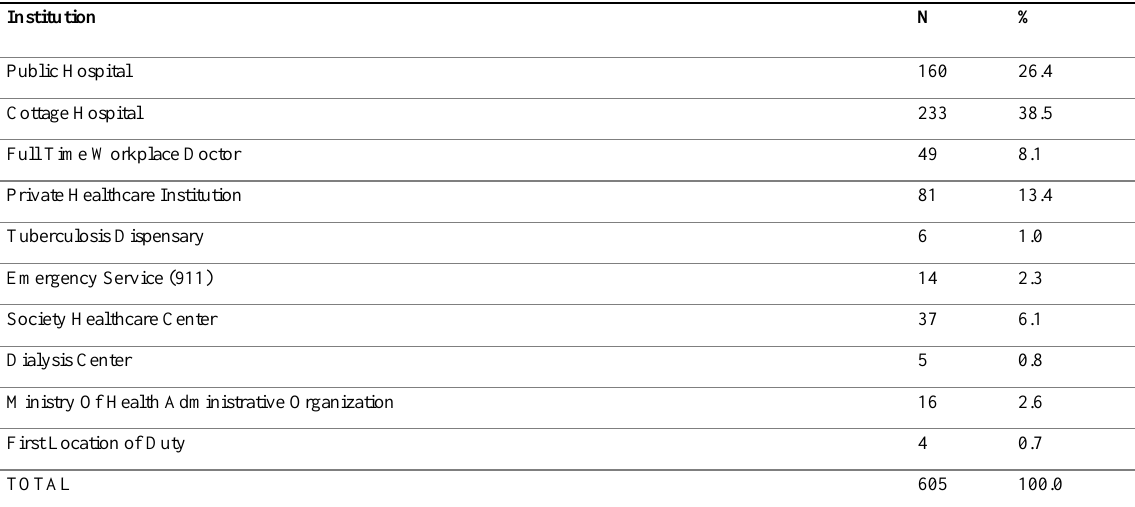
Table 4: Place of Duty before Family Healthcare